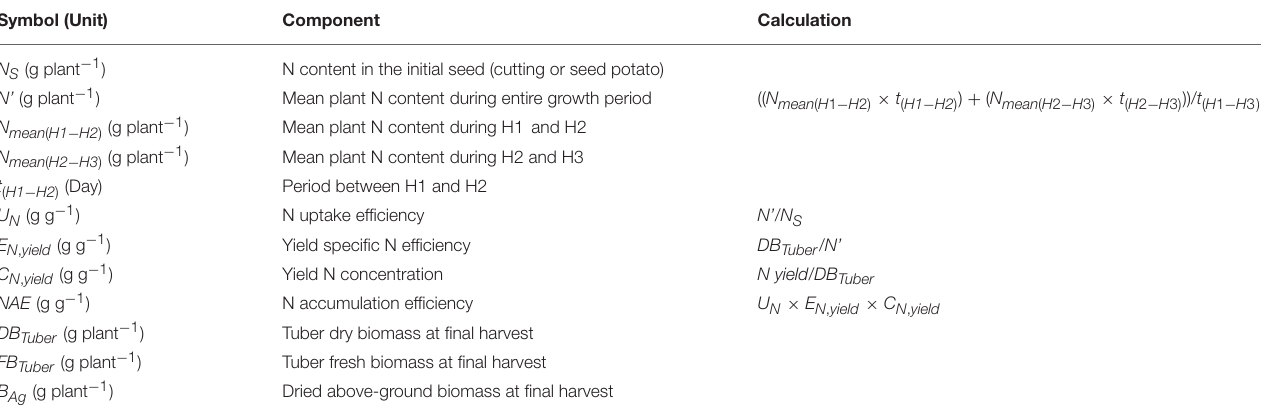
TABLE 2 | Calculation of whole-plant N use efficiency ( NAE ) and its components based on Weih et al. (2011), and the acronyms used in this manuscript. Symbol (Unit) Component